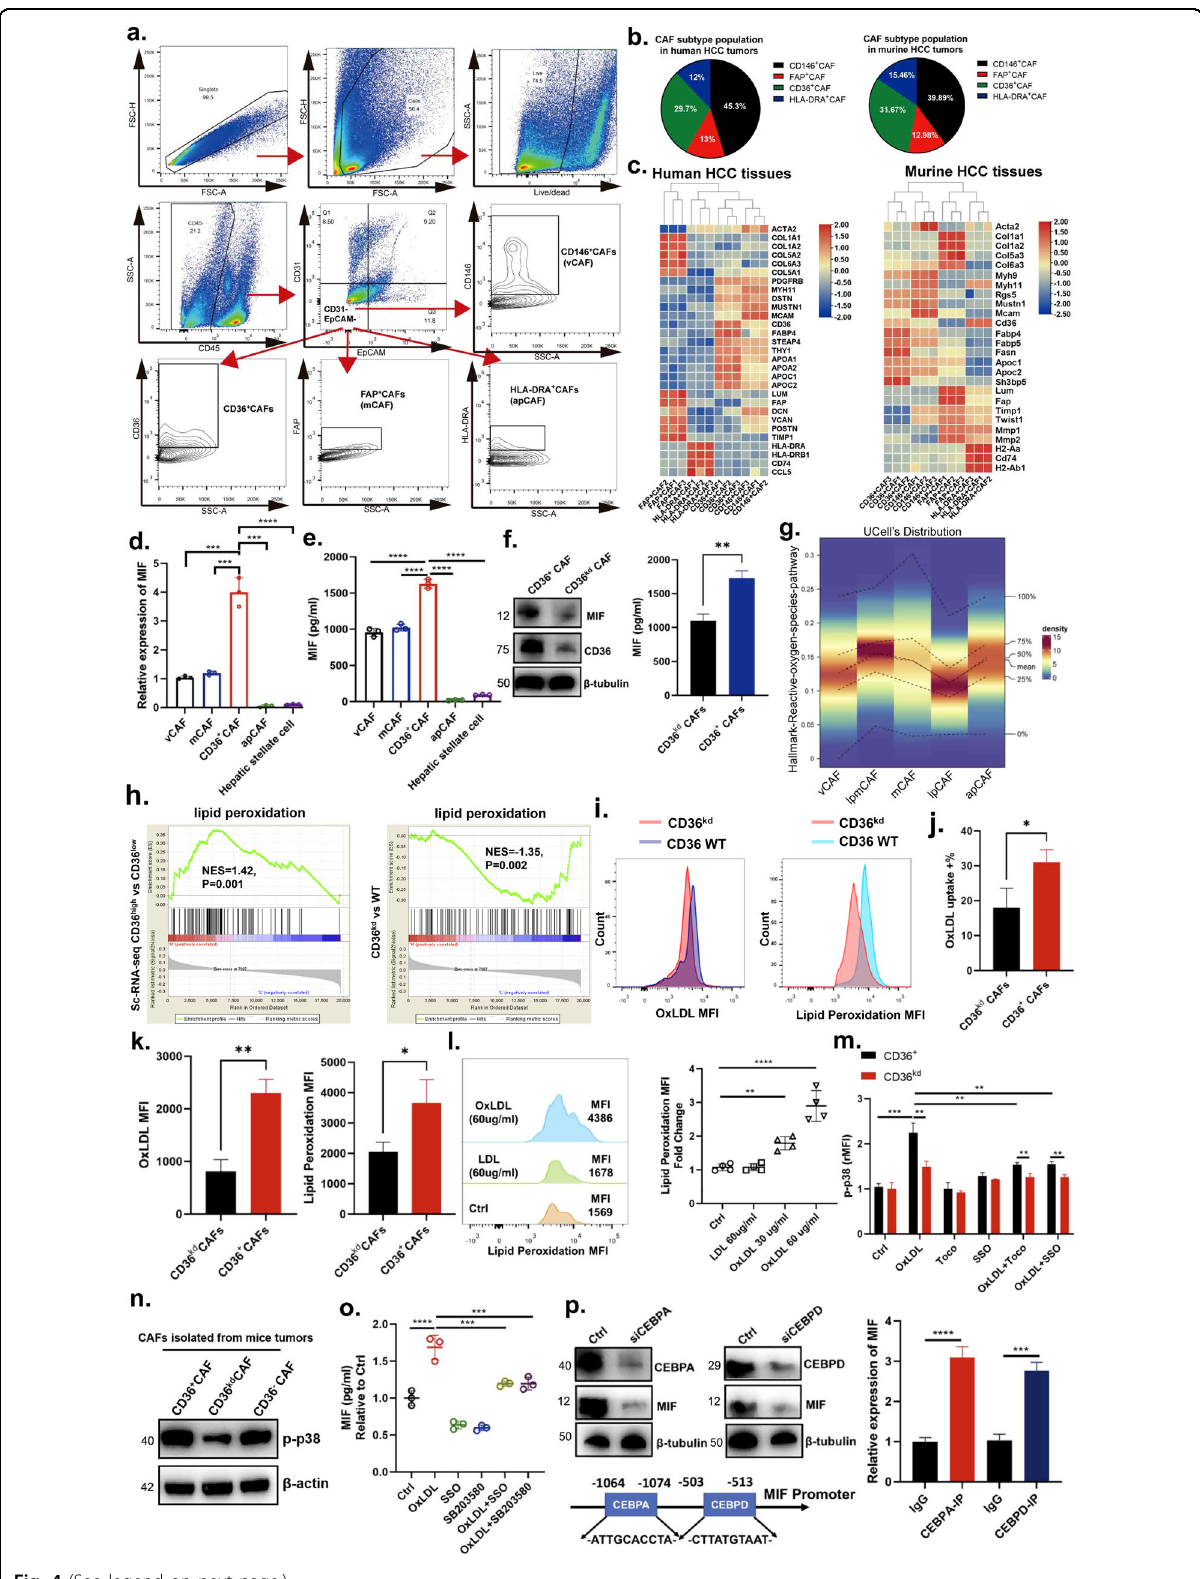
Fig. 4 (See legend on next